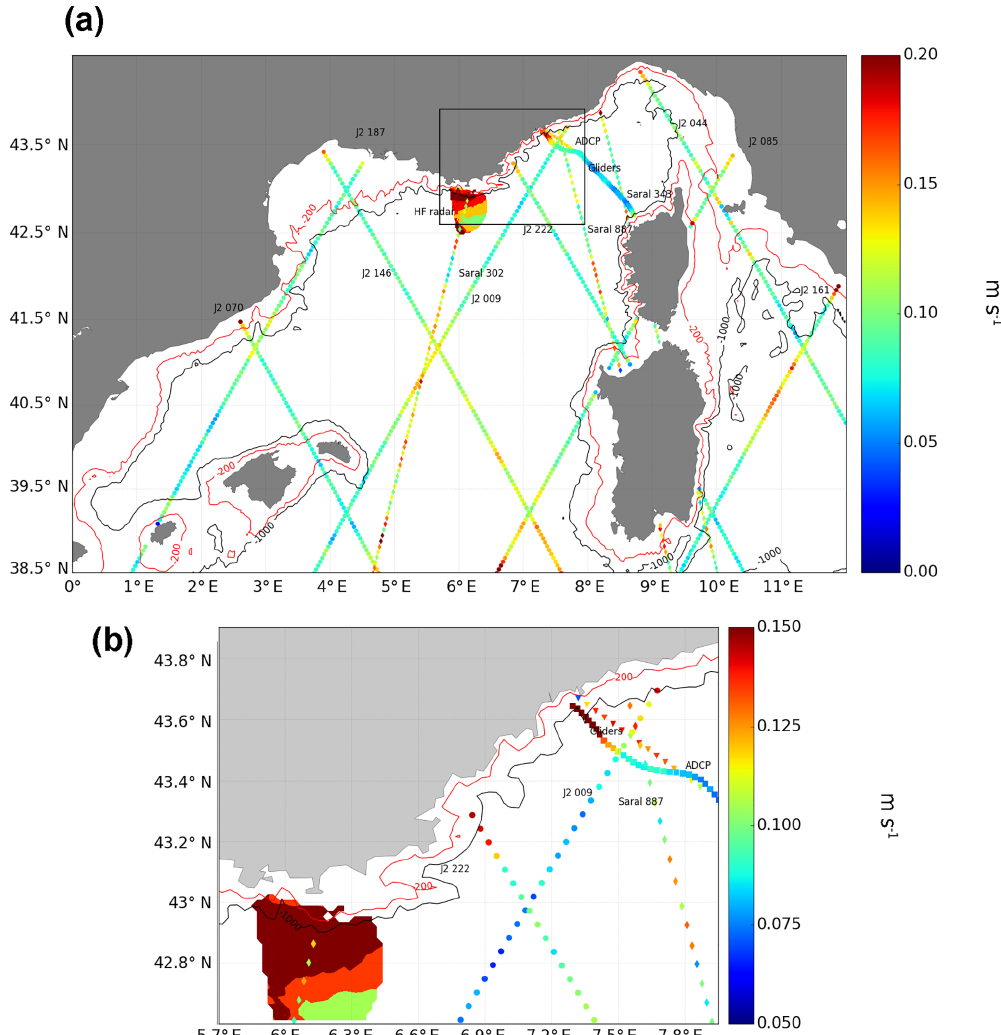
Figure 3. (a) Map of the standard deviations of the velocities derived from ADCP, glider, HF radar and altimetry data over the period March 2013–October 2014. (b) Zoom-in view of the northern Ligurian Sea (black rectangle indicated in panel a ); 200m (red line) and 1000m (black line) isobaths are also